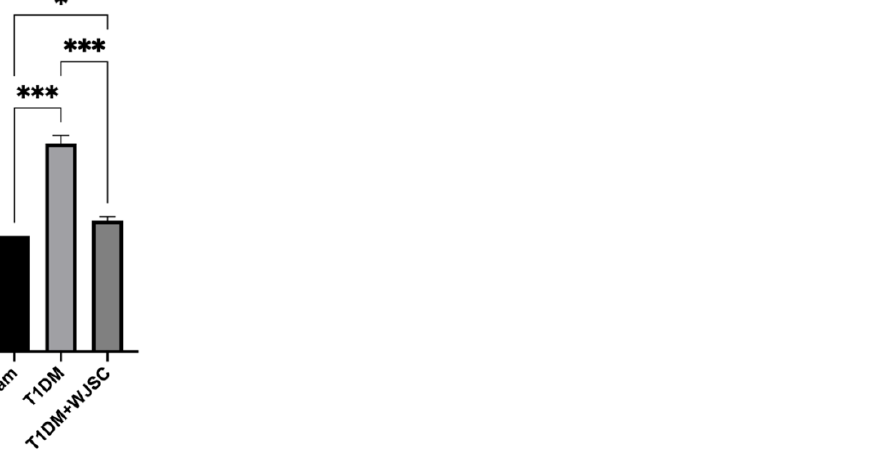
Figure 3. TBARS levels determination for heart tissues. * p < 0.05; *** p < 0.001.